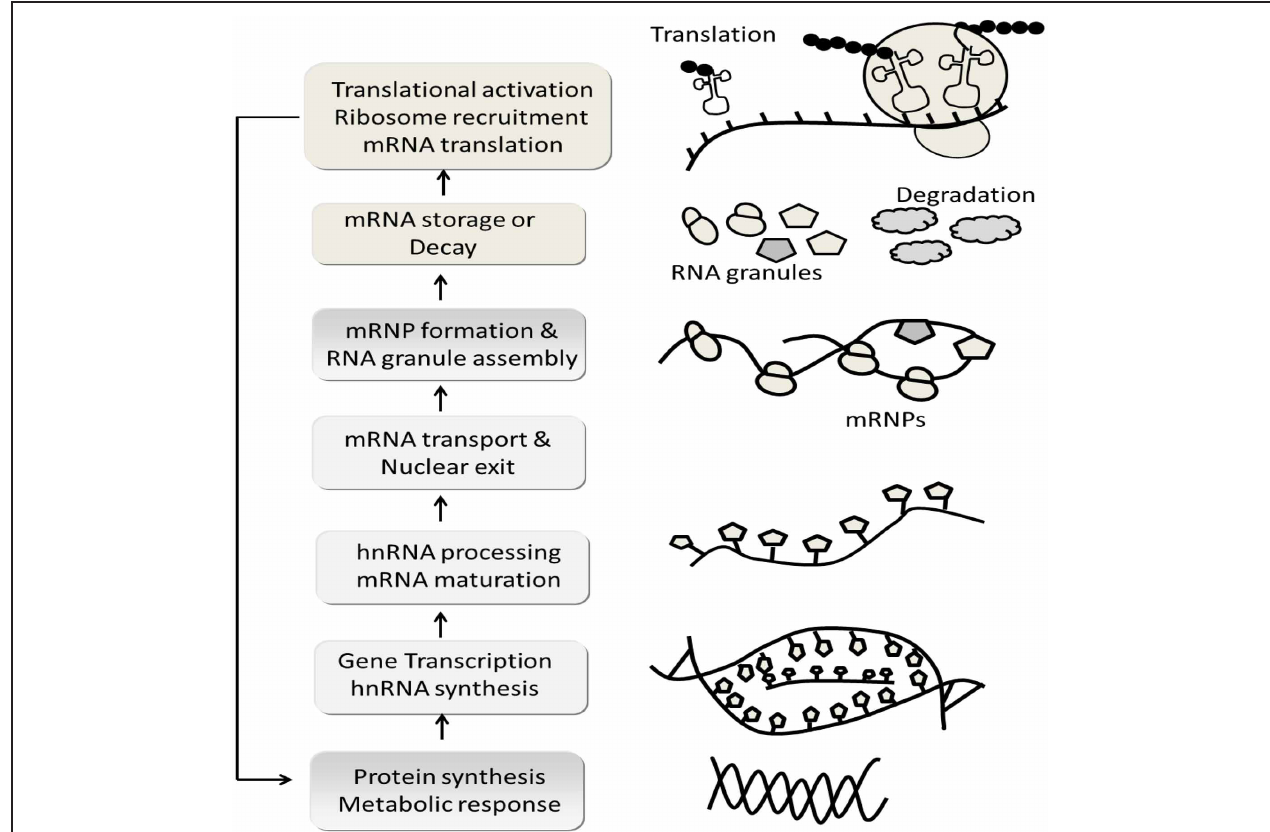
largely in the nucleus and is accompanied by the binding of mRNA with numerous RNA binding proteins that form messenger ribonucleoprotiens; mRNP), stability or decay of mRNA transcripts, initiation and elongation of mRNA translation, co/post-translation modification and intercellular transport and degradation of the expression protein. The model was adapted and modified from Adeli